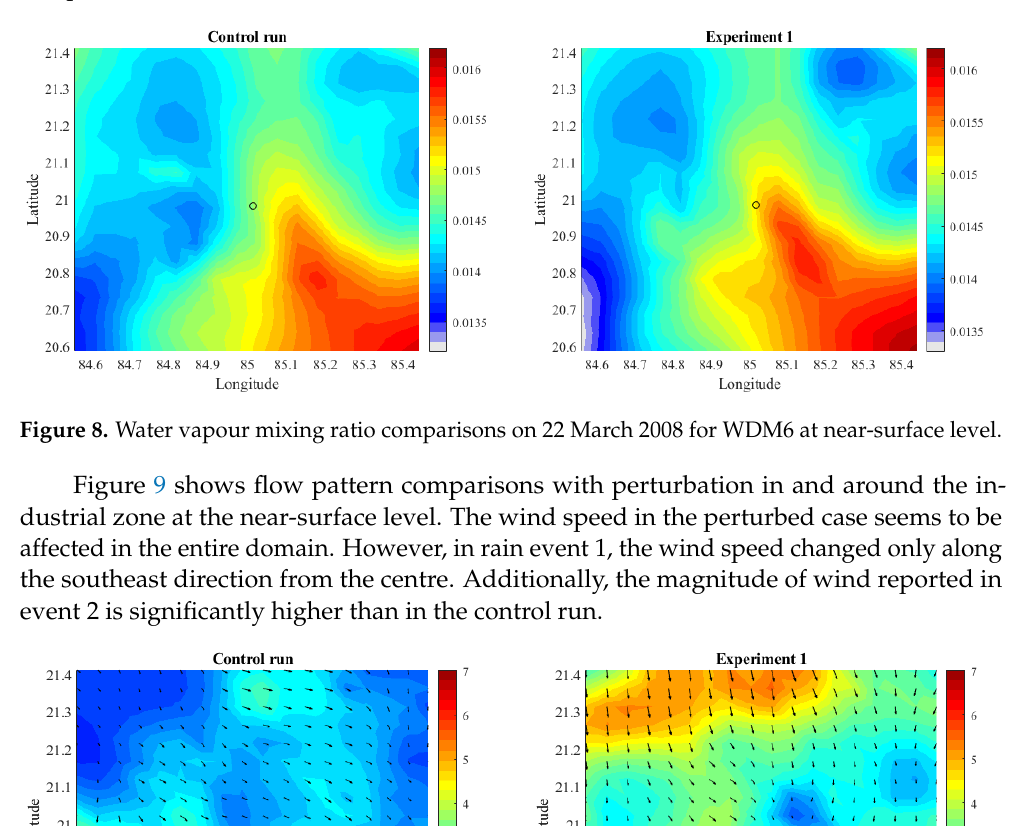
Figure 7. ( a ) Variation of Cloud number concentration on 16 August 2008 with vertical height, ( b ) Variation of Rain number concentration on 16 August 2008 with vertical height .